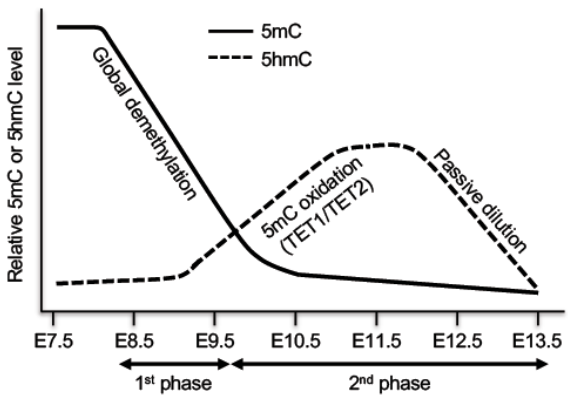
Figure 4. DNA demethylation in primordial germ cells (PGCs). PGCs undergo DNA